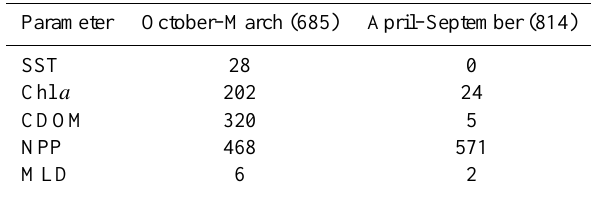
Table 2. Number of missing values for each parameter for the satel- lite data for the October–March and April–September periods. The numbers in parentheses indicate the total data points in each period.